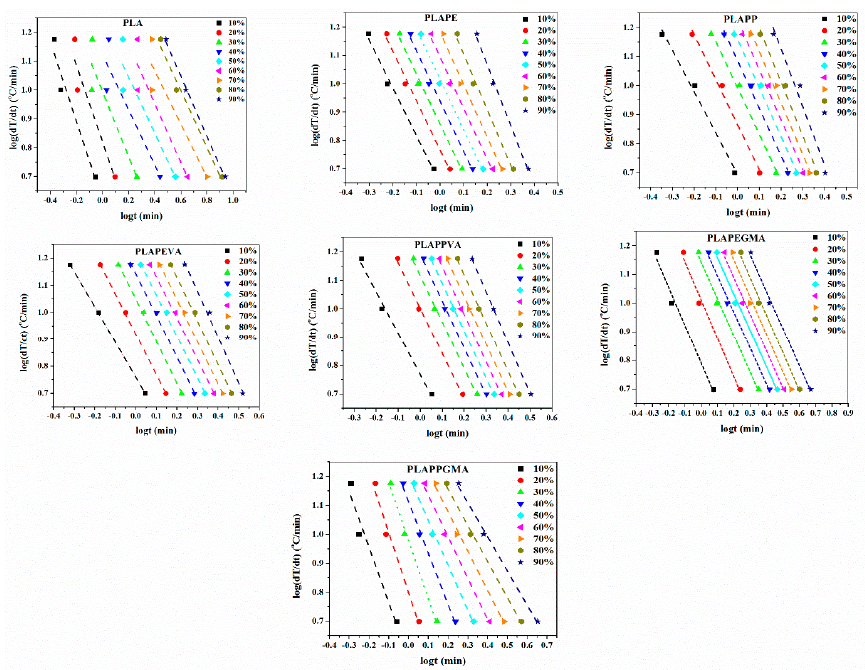
Figure 8. Plots of the cooling rates as a function of cooling time for the neat PLA and PLA / POE (80 / 20) with and without compatibilizer. Compatibilizers, EVA and EMA-GMA, were used at 4% phr.